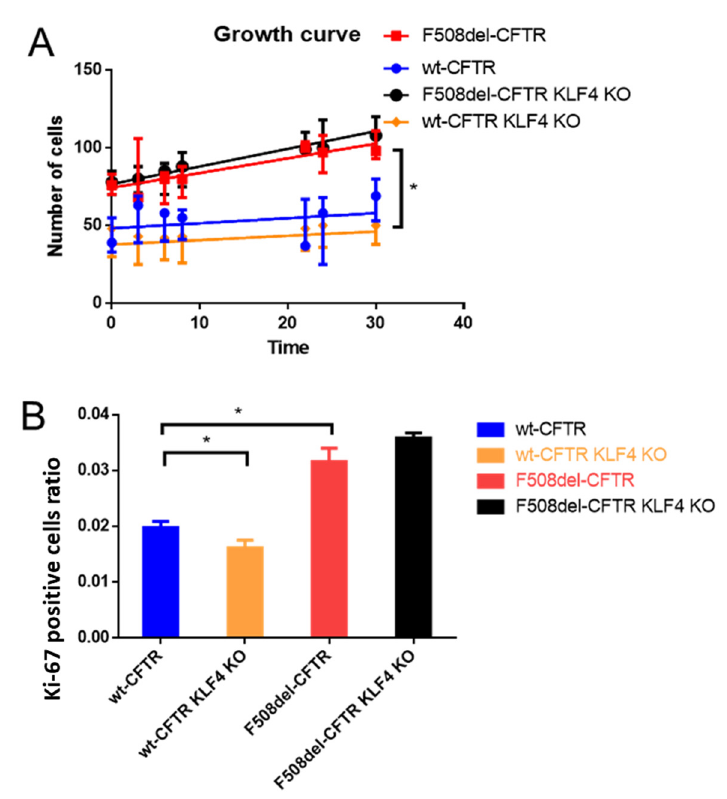
Figure 1. Impact of KLF4 knockout (KO) on cell proliferation, as assessed by growth curves and the proliferation marker Ki67 by immunofluorescence. ( A ) Growth curves of wt- and F508del-CFTR CFBE cells and their KLF4 KO counterparts ( n = 3). ( B ) Ki-67 positive staining data, as assessed by the ratio of Ki67 positive cells over the total number of cells. ( n = 3, unpaired t -test, asterisk is p < 0.05).